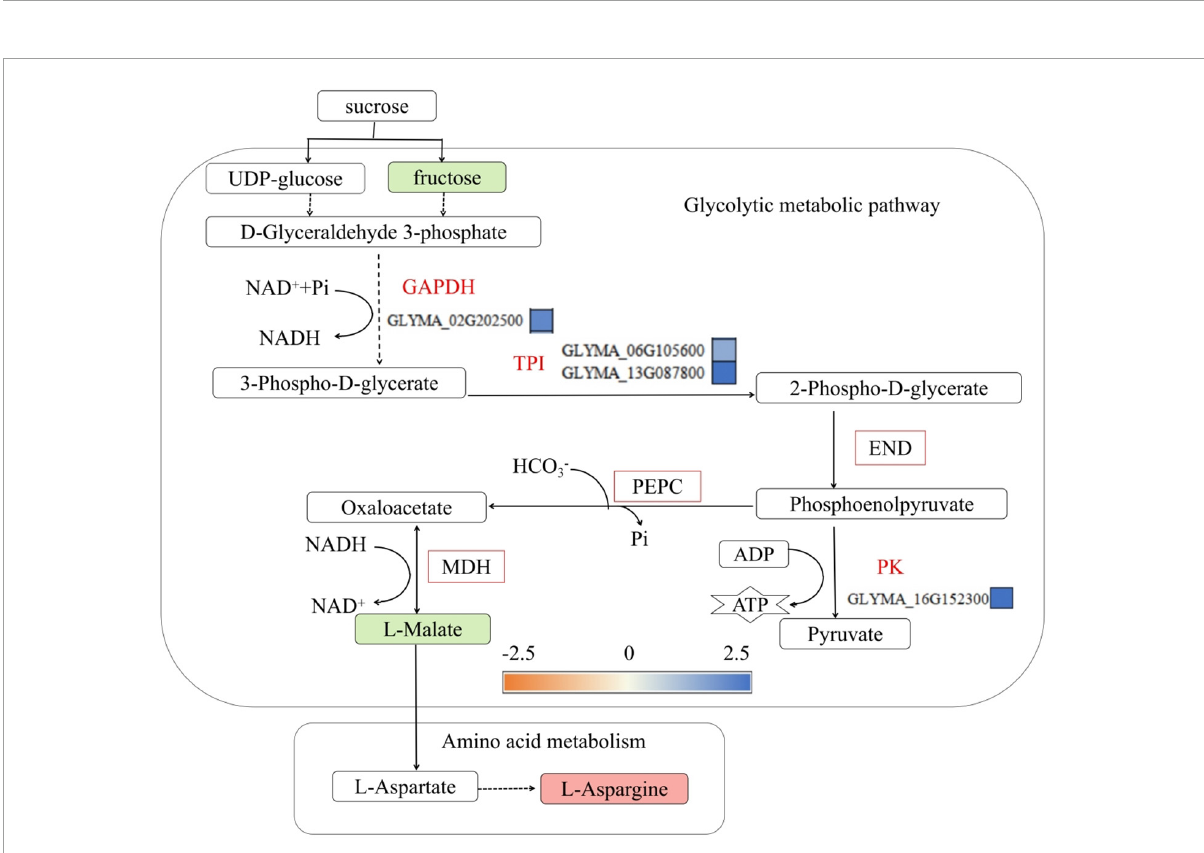
FIGURE8 Glycolytic metabolic pathways involved in phosphorus transport in soybean roots. FBA, fructose 1,6-bisphosphate aldolase; GAPDH, glyceraldehyde-3-phosphate dehydrogenase; TPI, phosphoglycerate isomerase; END, Enolase; PEPC, phosphoenolpyruvate carboxylase; MDH, malate dehydrogenase. The green solid squares indicate downregulated metabolites, red solid squares indicate upregulated metabolites, red font indicates upregulated genes, green font indicates downregulated Genes, red squares represent upregulated proteins, and yellow and blue squares represent fold changes in gene